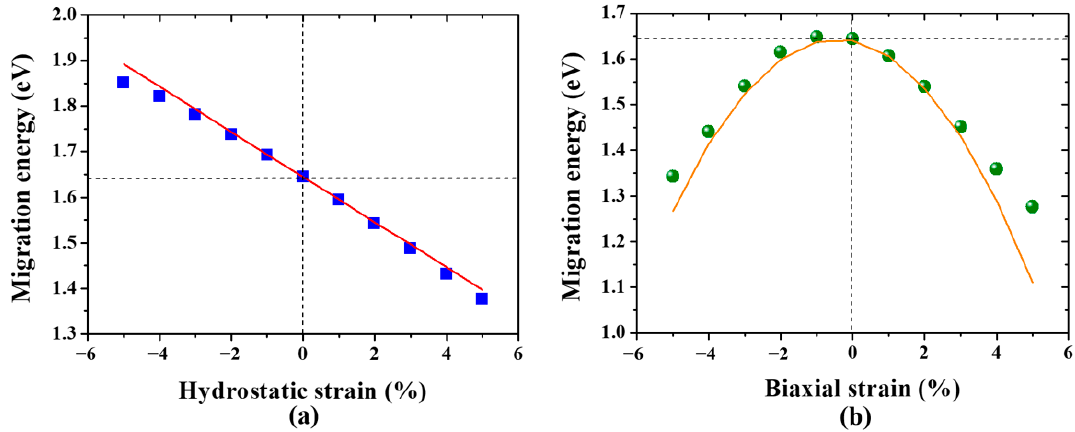
Figure 5. The migration energy of a monovacancy in W under ( a ) hydrostatic strain and ( b ) biaxial strain. The predicted results (red and orange solid line) from elastic dipole tensor are also presented.